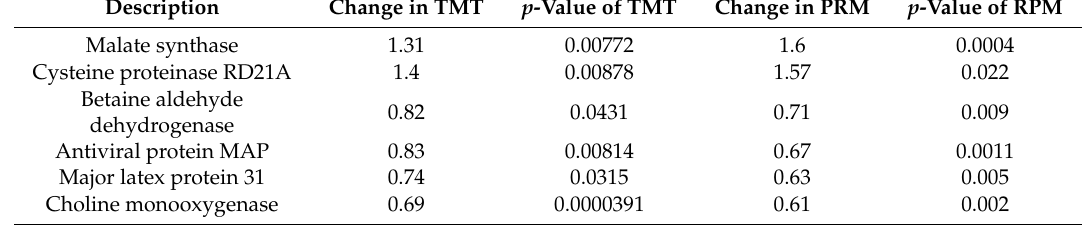
Table 1. Confirmation of DAPs in proteomic analysis using PRM analysis.